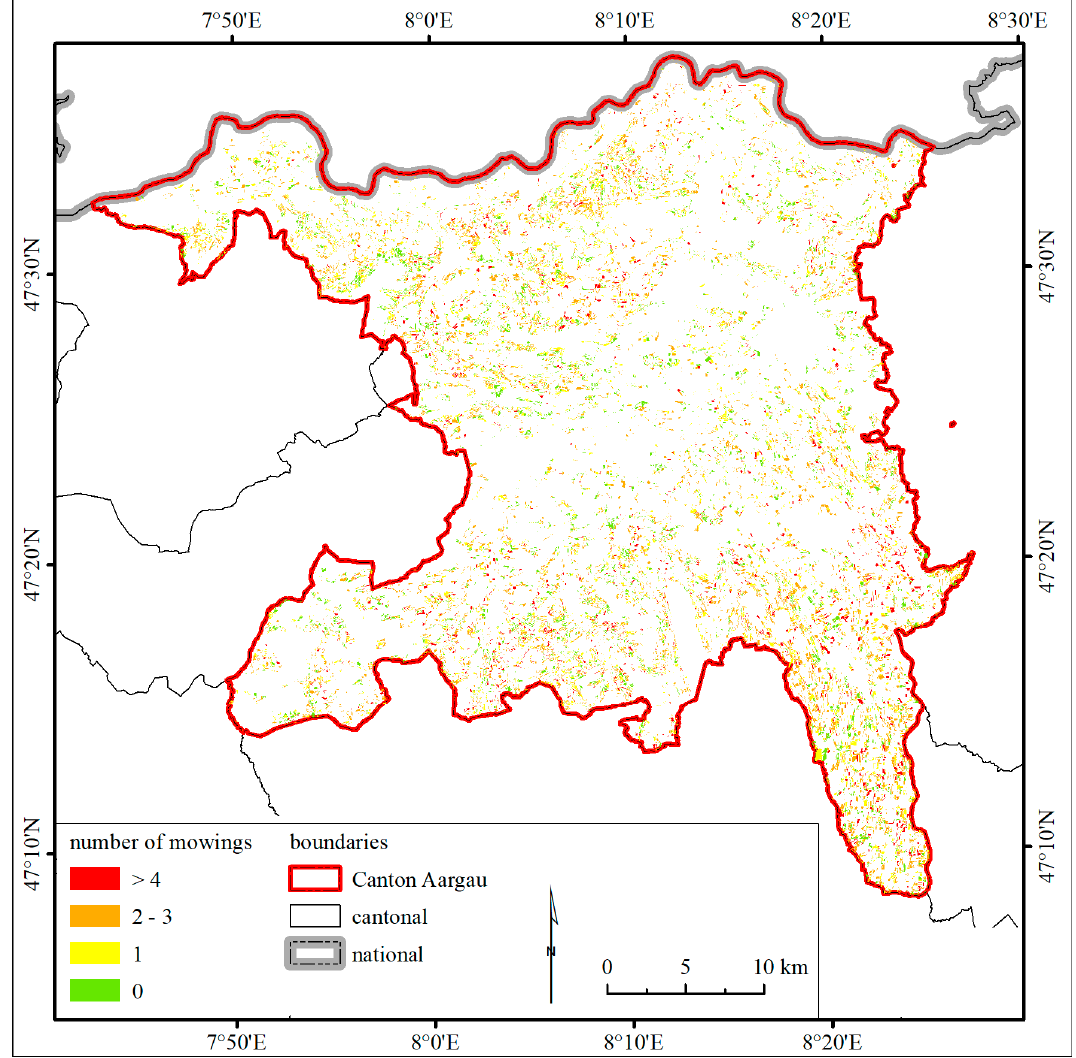
Figure 7. Mowing frequency map of Canton Aargau derived from optimized-shrunken-parcel. Table 2. Parcel characteristics of the agricultural land use types. The marginal land use types were not included. OP, other pastures (pastures at farm